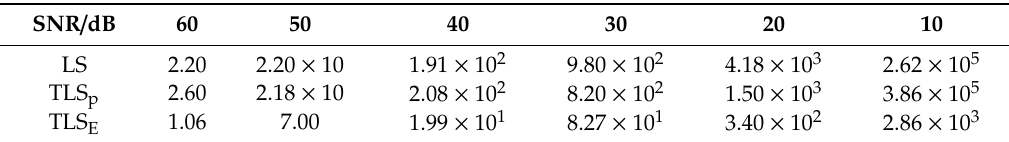
Table 2. IFs of di ff erent conditions.